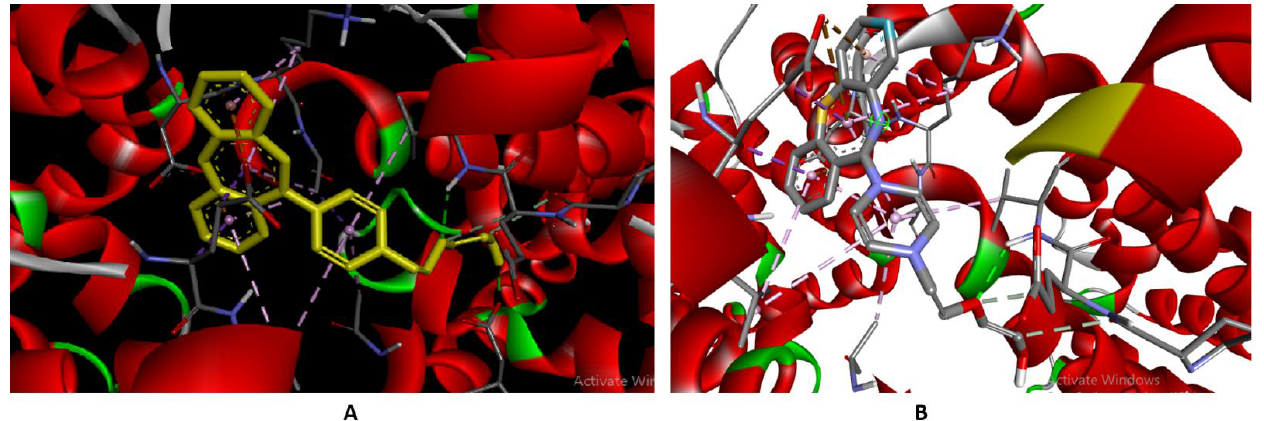
Figure 9. ( A ) Molecular models of HSA complex with QTP. ( B ) Detailed view of the docking poses of the HSA-QTP complex. Selected protein side-chains are shown as ribbons.